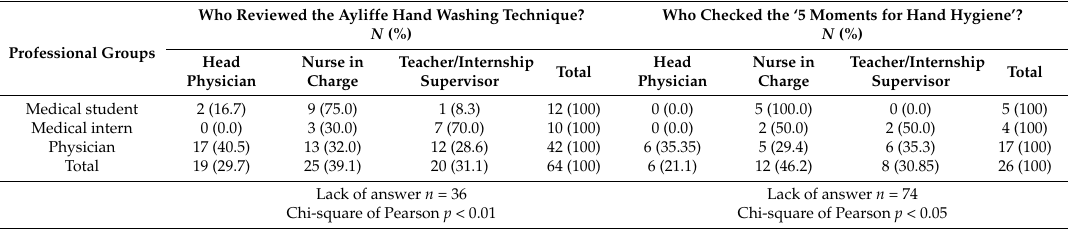
Table 4. Answer the question: Who checked your Ayliffe hand washing technique and the 5 Moments for Hand Hygiene [2,3]?